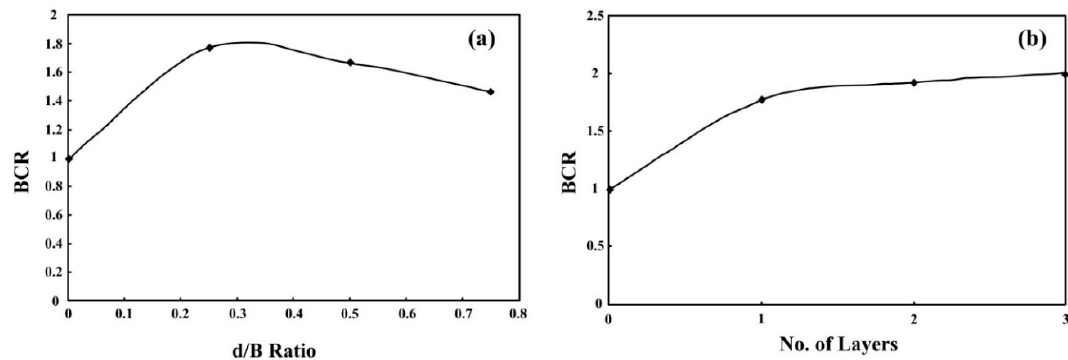
Figure 8. Bearing capacity ratio ( BCR) variation against ( a ) the d/B ratio of the single-layer system and ( b ) the number of reinforcing layers (modified from Asaduzzaman and Islam [32]). Minerals 2020 , 10 , x FOR PEER REVIEW 13 of 22